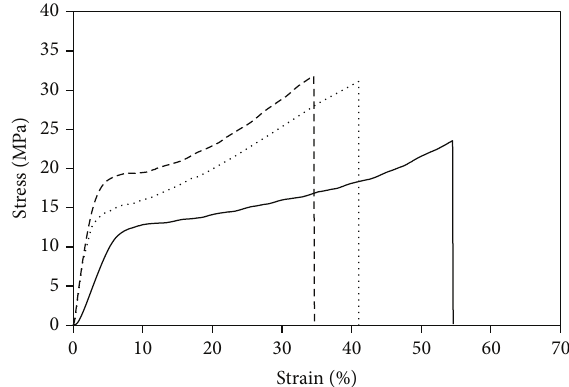
Figure 1: Typical curves for the tensile properties of the nanocom- posites prepared with 5 g of gelatin/100 g of NFS and 0 (—), 5 ( ⋅⋅⋅ ), and 10 (---) g of MMT/100g of